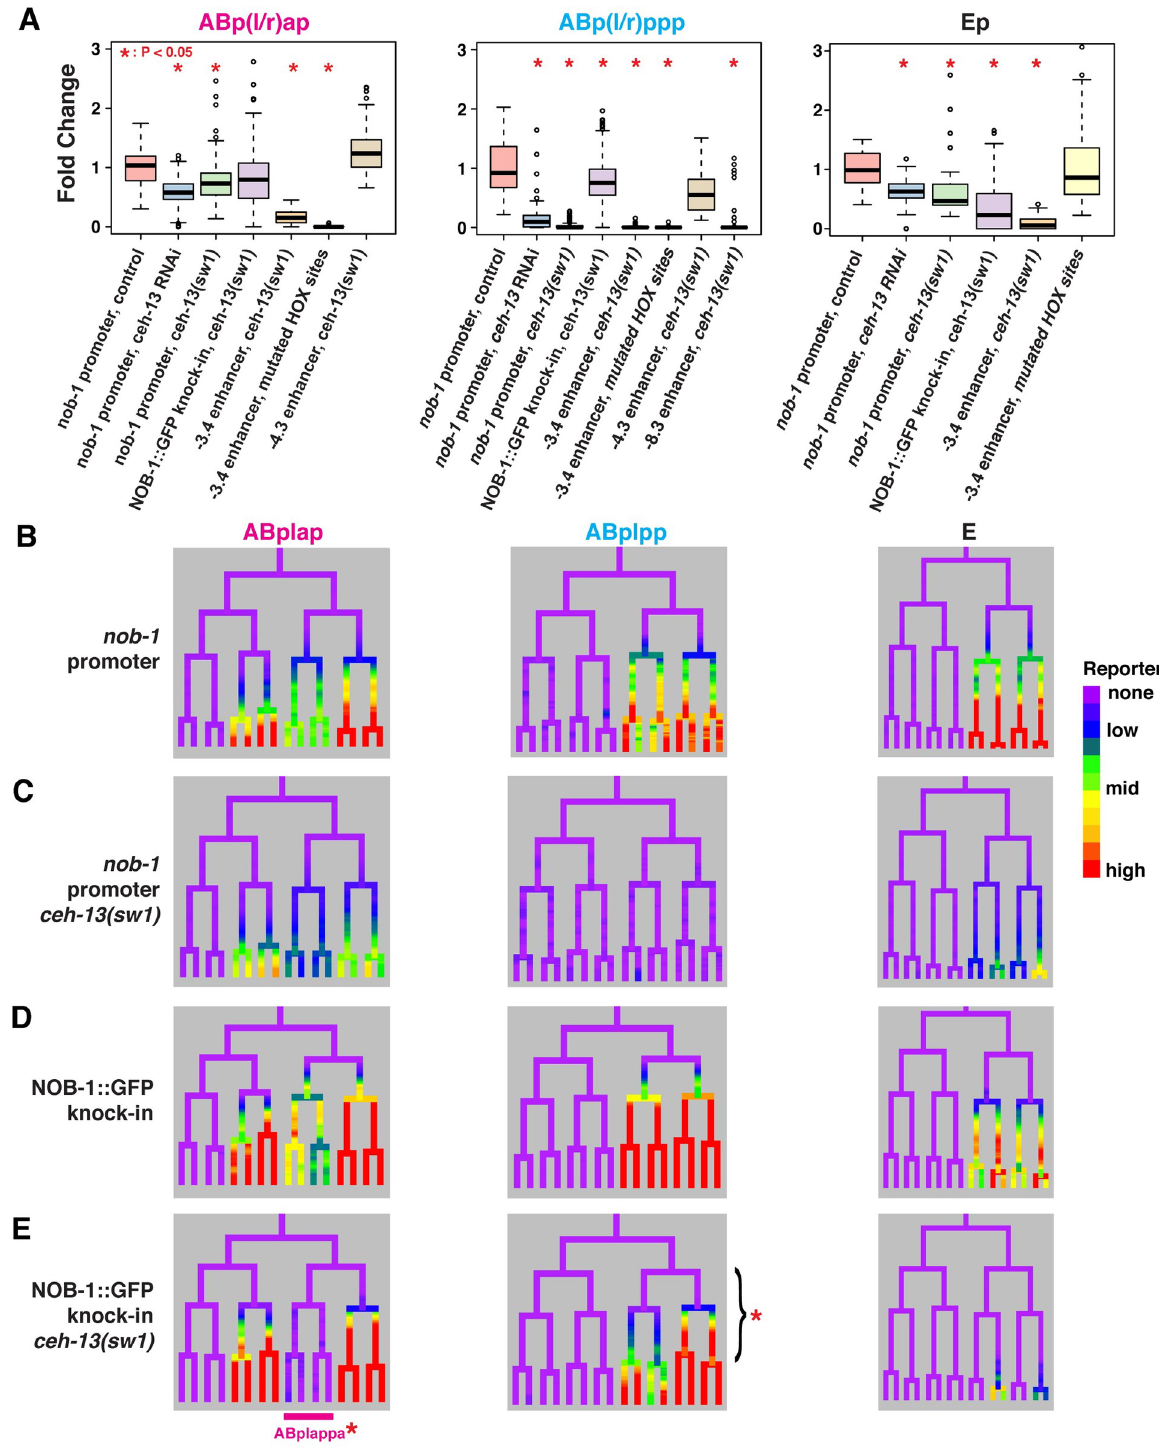
Fig 3. Expression of cis-regulatory elements upstream of nob-1 and php-3 depends on ceh-13 . A) Fold change in expression level relative to mean wild-type control for nob-1 promoter, endogenously tagged NOB-1::GFP knock-in allele, and enhancer reporters in ceh-13 mutant and RNAi conditions. Number of biological replicates for each condition ranges from 3–16, however, since there are, for example, 36 nob-1 cells in the ABp(l/r)ap lineages, the number of points represented by the box plots is much greater. P values determined by Wilcoxon Ranked Sum Test, p < 0.05 significant. B) Lineage view of wild-type nob-1 –5.3kb upstream reporter (“promoter”) expression in specified lineages. C) -5.3kb